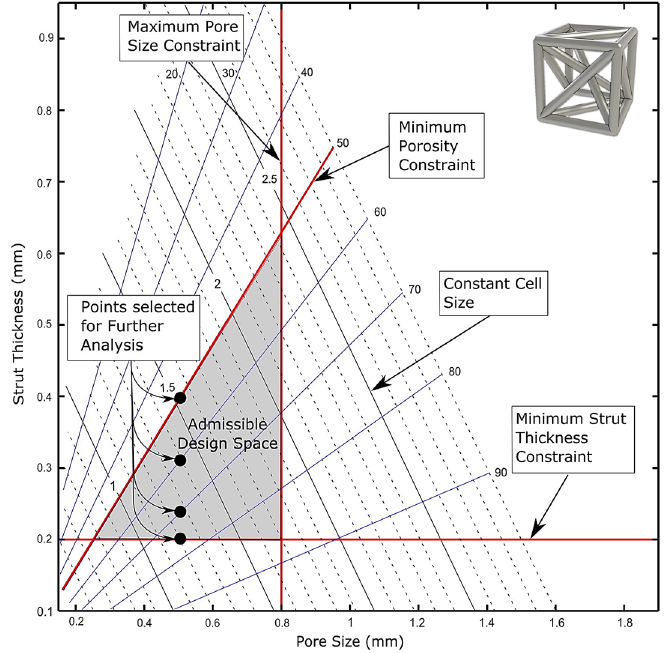
Figure 5. Design area for Tetrahedron topology, with the constraints of manufacturing, pore size, and porosity. Reprinted with permission from ref. [84]. 2016, Elsevier Ltd.